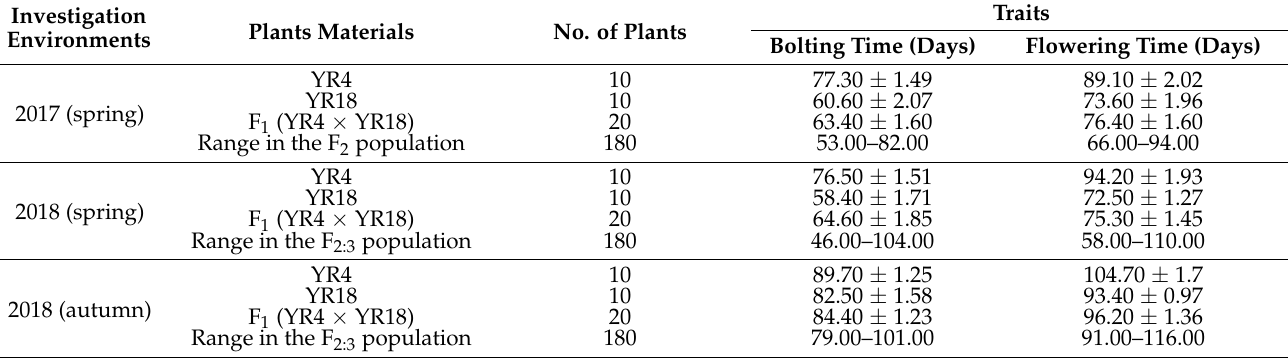
Table 1. Summary of bolting and flowering time traits in the parental lines, F 1 and F 2:3 population. Investigation Environments Plants Materials No. of